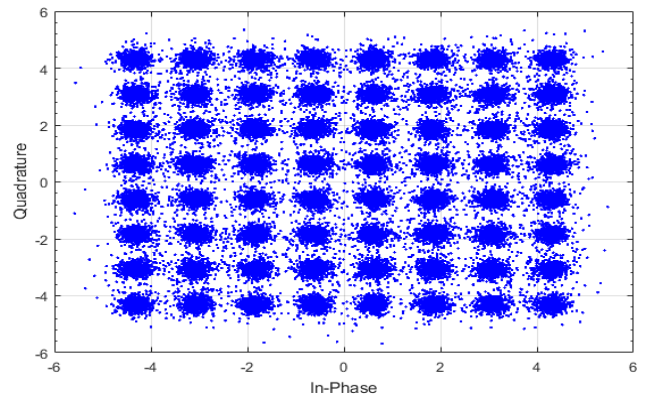
Figure 10. QAM scatter plot received symbols without FFB. Distortion due to clipping with PA model.